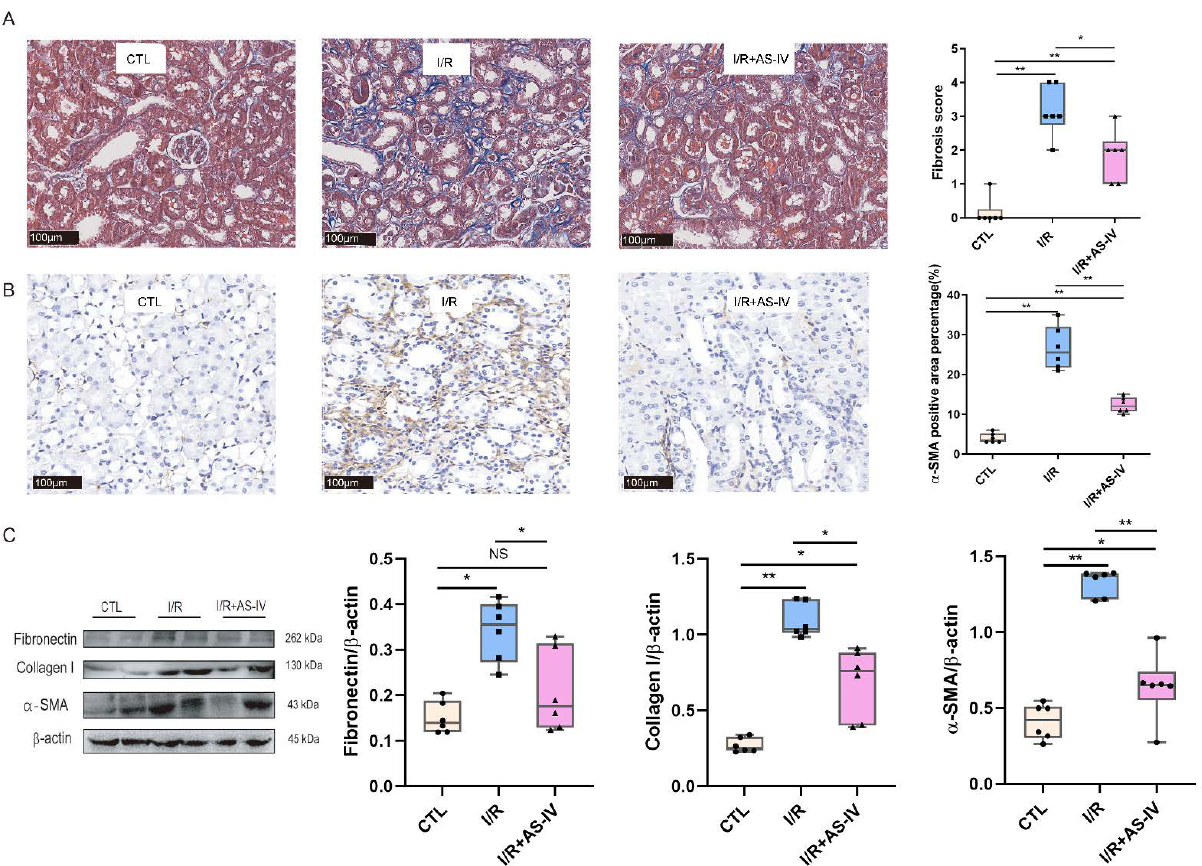
Figure 6. AS-IV attenuates kidney fibrosis 28 days after I/R. ( A ) Representative Masson staining (blue area) of renal tissue sections (magnification ×200). ( B ) Immunohistochemistry staining of α -SMA. The brown areas represent positive expression of α -SMA (magnification × 200). ( C ) Western blot results of fibrotic proteins (Fibronectin, Collagen I, and α -SMA) in renal tissues 28 days after I/R. n = 6 in each group, * p < 0.05, * * p < 0.01.